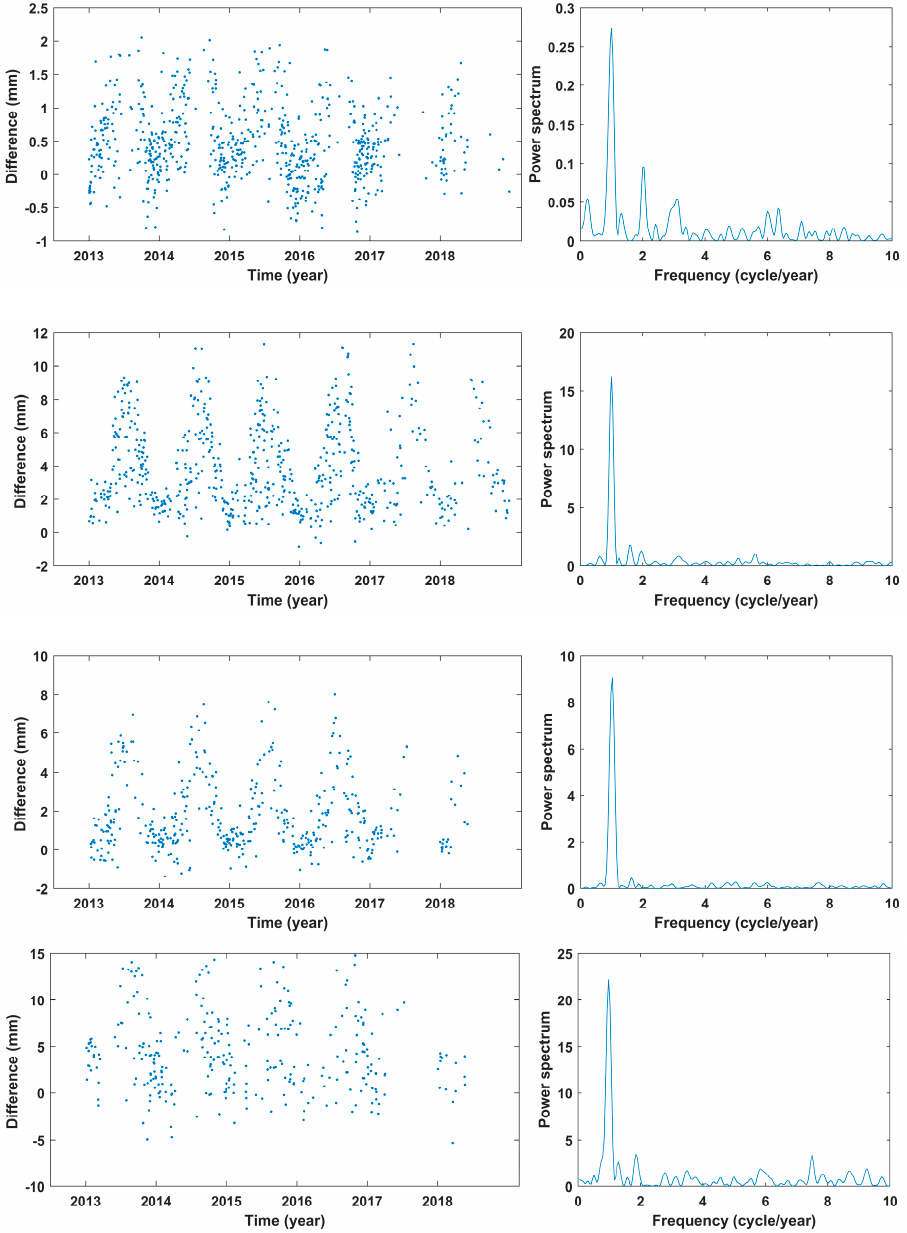
Figure 11. Difference (in millimeters) between ERA-PWV and MOD-NIR-PWV ( left ) during the six-year period studied at four randomly selected grid points, and their Lomb–Scargle periodograms ( right ).